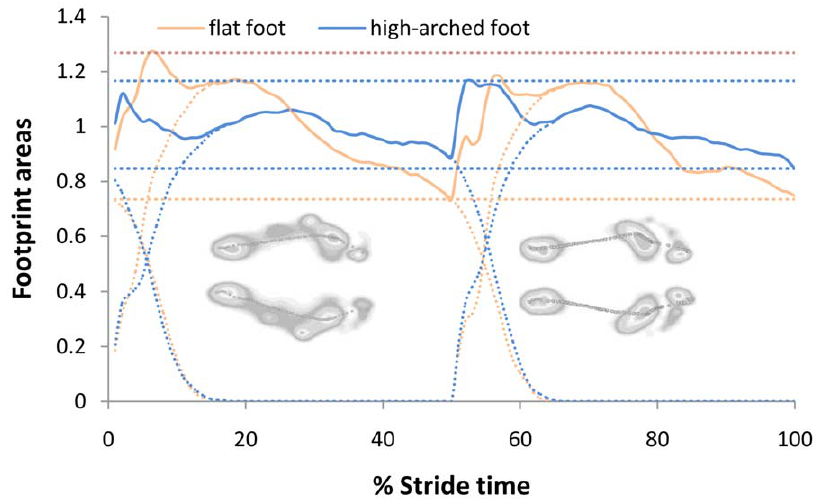
Figure 4. Relationship between the footprint areas and stride time. The blue (deep) dotted lines refer to the plantar stance areas of the high- arched left and right foot while the blue (deep) solid line the sum of plantar stance area of the high-arched. The blue (deep) horizontal dotted line presents the variation range of the sum of plantar stance area of the high-arched. The red (light) dotted lines stand for the plantar stance areas of the flat left and right foot while the red (light) solid line for the sum of plantar stance area of the flat-footed. The red (light) horizontal dotted line presents the variation range of the sum of plantar stance area of the flat-footed. The footprint area is derived from the test report of Zebris FDM and the sum of plantar stance area is obtained from A sum t ð Þ ~ A left t ð Þ z A right t z t o ð Þ . According to the least-action principle in gait, t o ~ 1 cycle time.